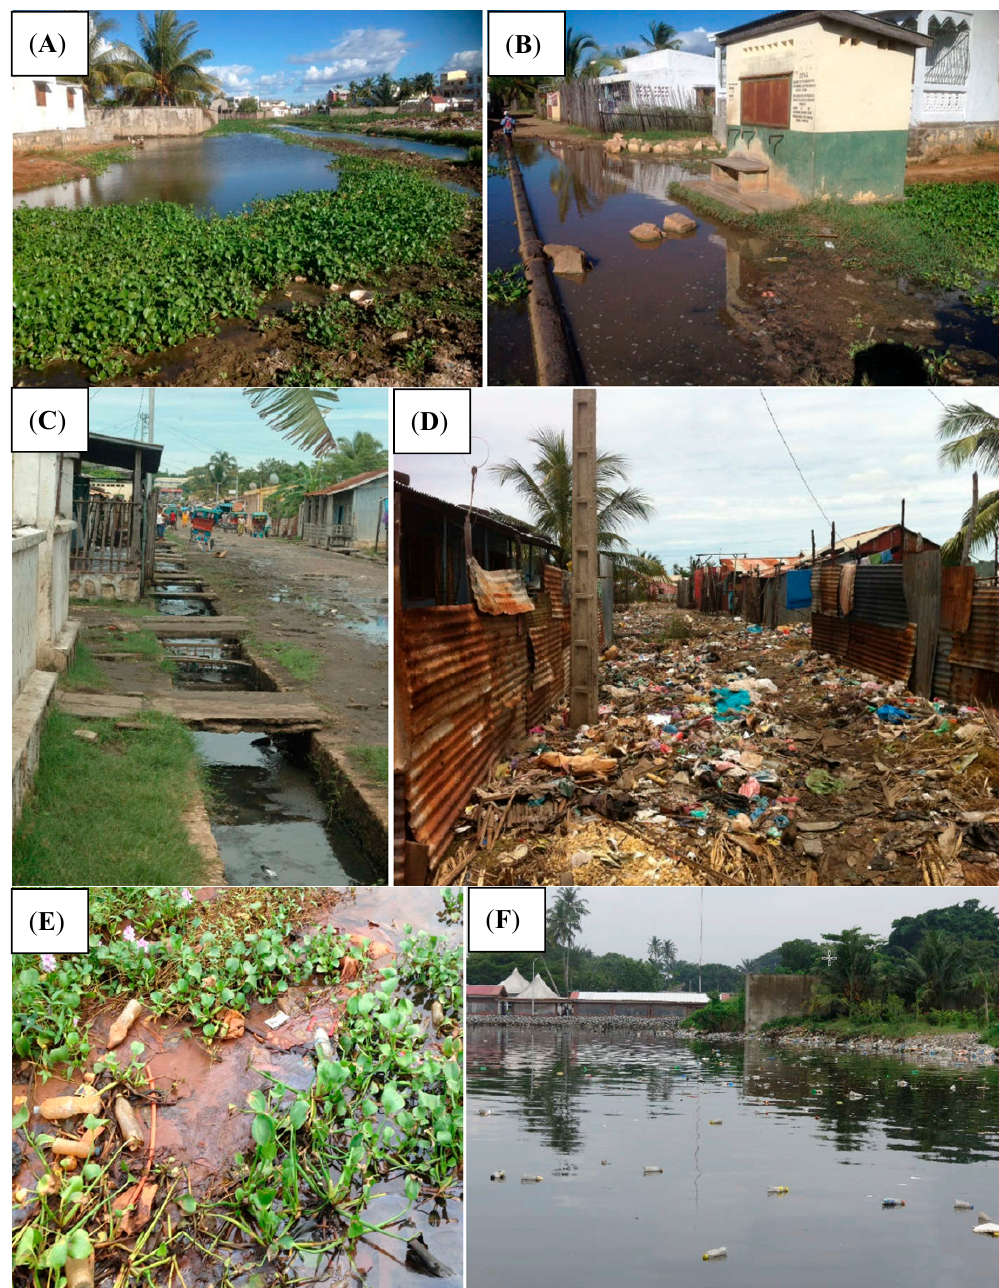
Figure 1. Plastics and garbage in an open sewer network; ( A – D ) Mahajanga, Madagascar, 2014, ( A,B ) open sewer network, (C) standpipe in a flooded area, (D) garbage pen in an area liable to flooding; ( E , F ) Ébrié Lagoon in Abidjan, floating plastics.